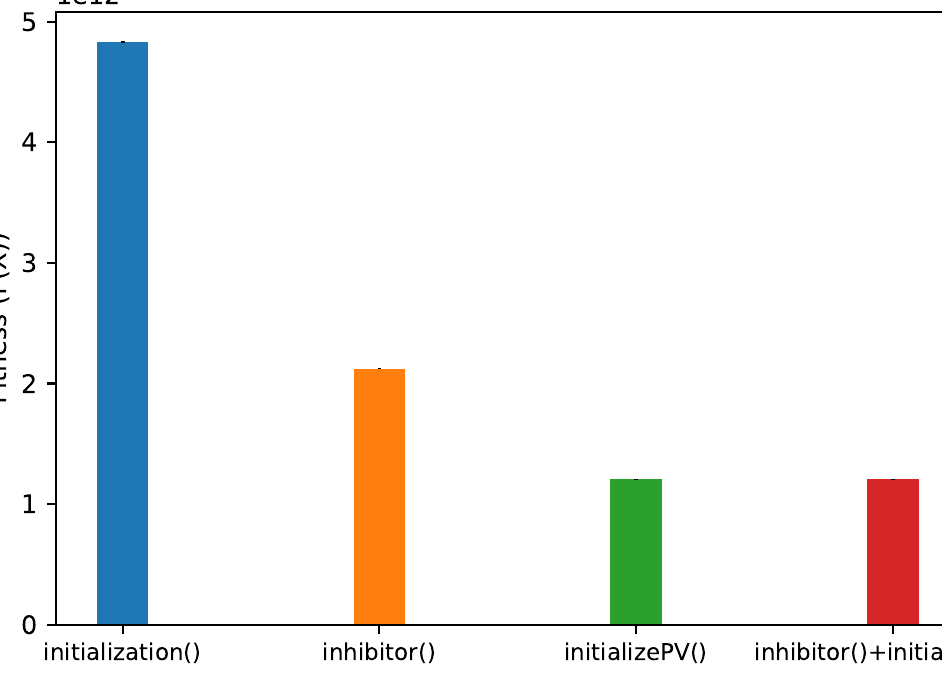
Figure 5. Casting scheduling problem: fitness of trials generated using different PV initialization strategies (mean ± std. dev. across 1000 trials). Here, initialization() indicates a random initialization of PV . Note that in these experiments the mutation operators are not applied, thus any violated constraint is not repaired. While it seems that initializePV() alone is enough to generate good trials at the beginning of the algorithm, inhibitor() blocks the bits also during the